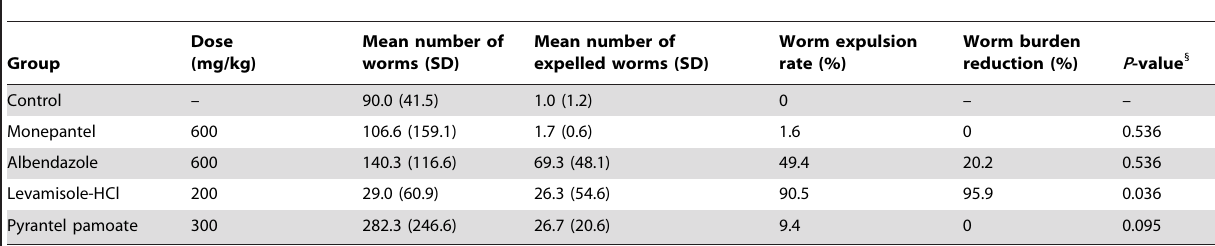
Table 5. Effects of monepantel, albendazole, levamisole, and pyrantel pamoate on T. muris in vivo .